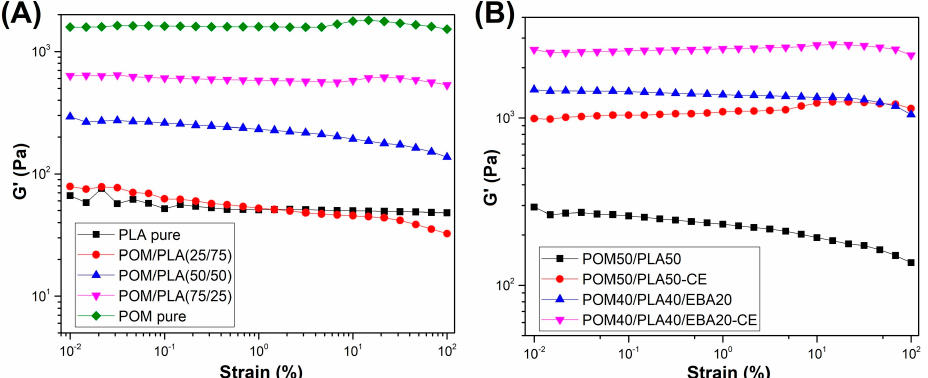
Figure 4. Strain sweep measurement plots for unmodified POM / PLA blends ( A ) and modified POM50 / PLA50 blends ( B ).